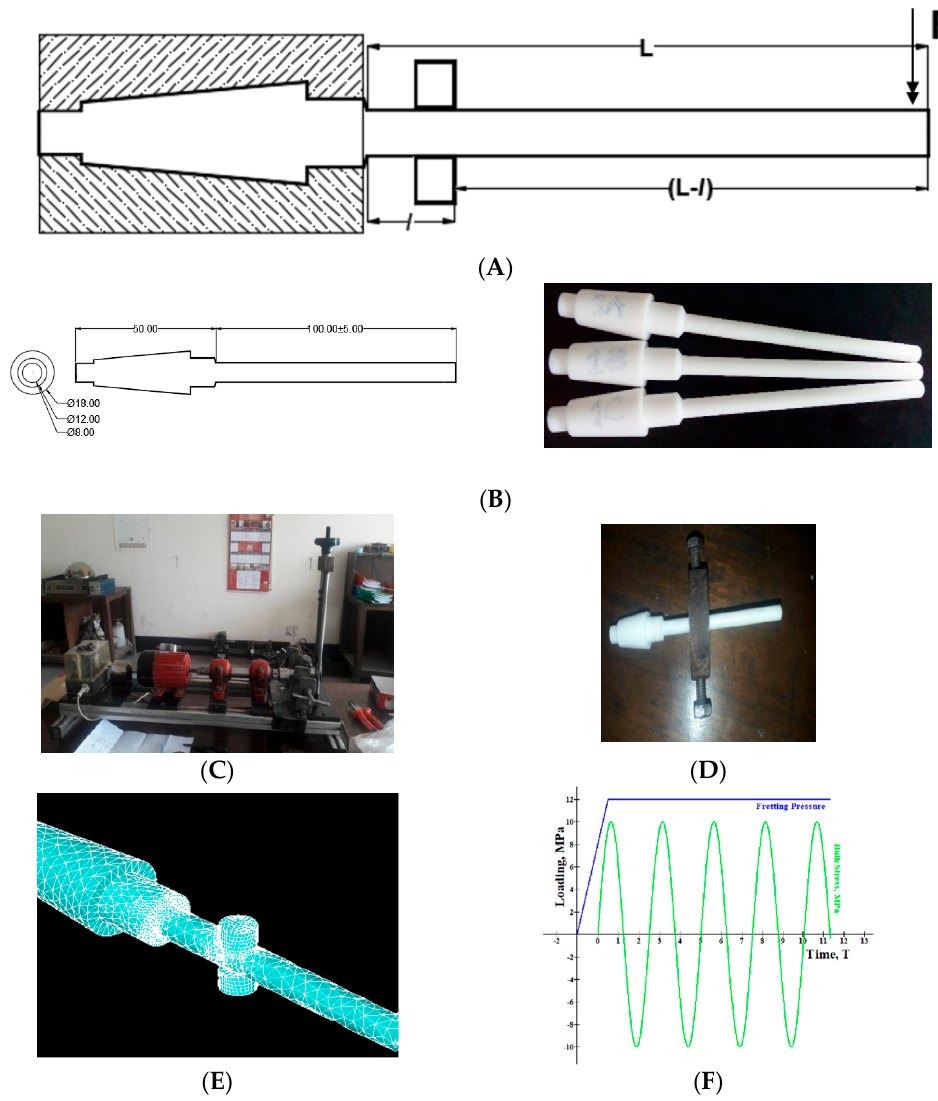
Figure 3. ( A ) cylindrical cantilever beam under bending fretting fatigue. ( B ) Designed specimen (dimensions are in mm). ( C ) Meshed geometry ( D ) conditional loading, ( E ) rotating bending fatigue setup, and ( F ) fretting proving ring.